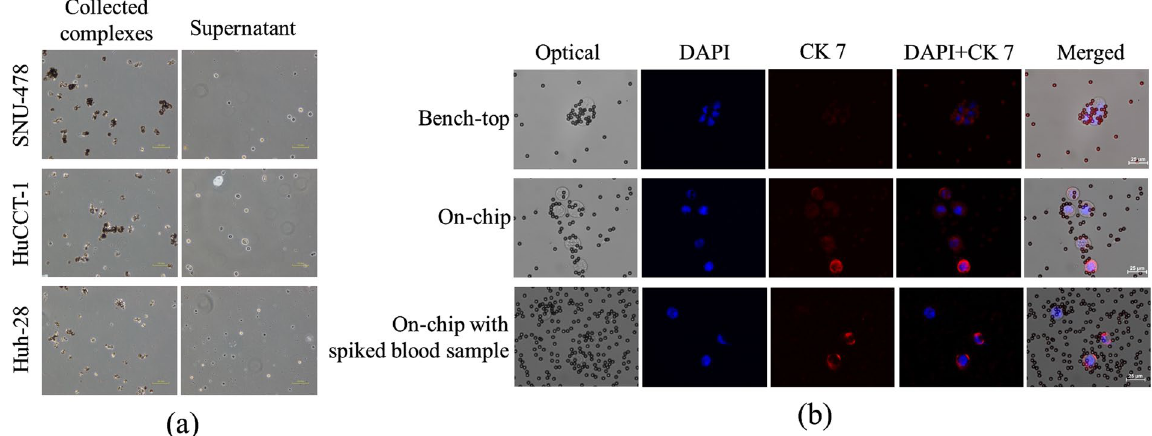
Figure 2. ( a ) On-chip cell capture was tested with three cholangiocarcinoma (CCA) cell lines- SNU-478, HuCCT-1, and Huh-28. ( b ) On-chip immunofluorescence (IF) staining was tested with SNU-478 cells (bench- top and on-chip), and SNU-678-spiked blood samples (on-chip